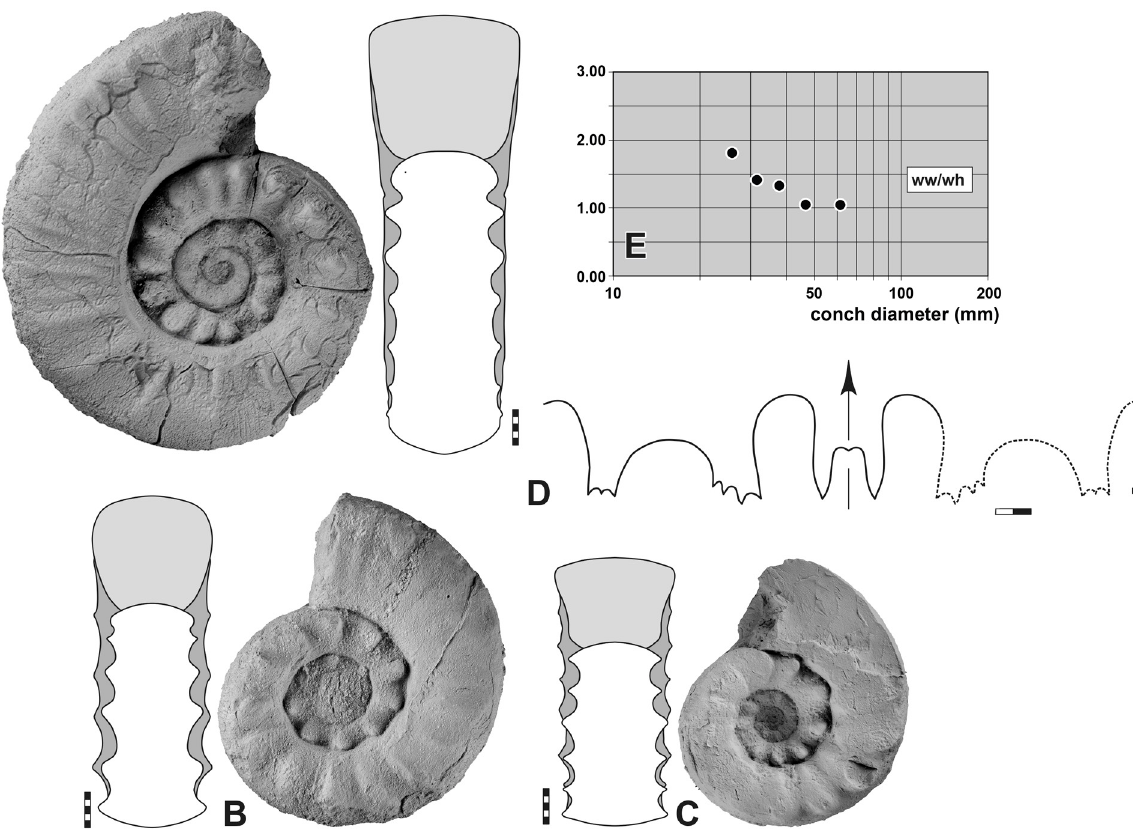
Fig. 40. Paratirolites serus Korn & Ghaderi, 2016. A . Lateral and dorsal view, specimen MB.C.29936, section E, float. B . Lateral and dorsal view, specimen MB.C.29934, section C, -0.60 m. C . Lateral and dorsal view, specimen MB.C.29937, section F, -0.75 m. D . Suture line, specimen MB.C.29934, at 16.0 mm ww, 10.3 mm wh. E . Whorl profile proportions. Abbreviations: see Material and methods. Scale bar units = 1